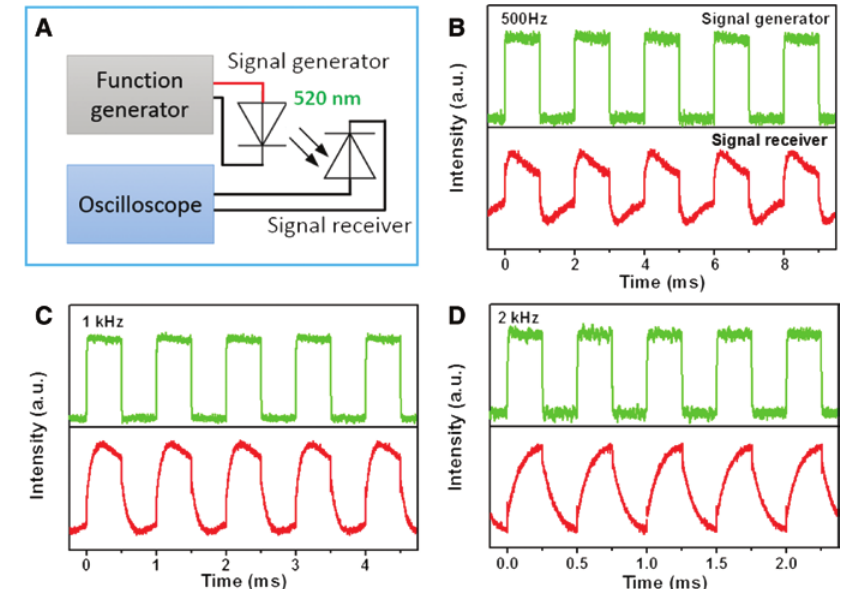
Figure 6: The demonstration of the visible light communication system. (A) The schematic diagram illustrating the use of two identical bi-functional diodes for application in high speed visible light communication, one performed as a signal generator and another diode, placed 0.5 m away, acted as a signal receiver. The modulated EL emission and the corresponding photo-response of a pair of the bi-functional diodes, performing the visible light communication capability, at different frequencies of (B) 500 Hz, (C) 1 kHz, and (D) 2 kHz, were clearly manifested. The diode that functioned as the signal generator was operated at a forward bias of 5 V, and the one acted as the receiver was operated at 0